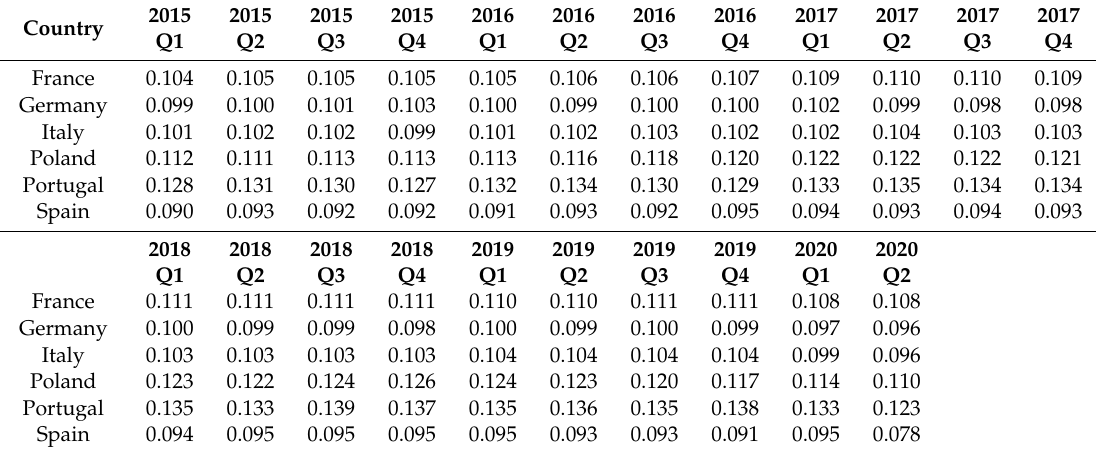
Table 2. Average tax rate, own work, source: Eurostat.